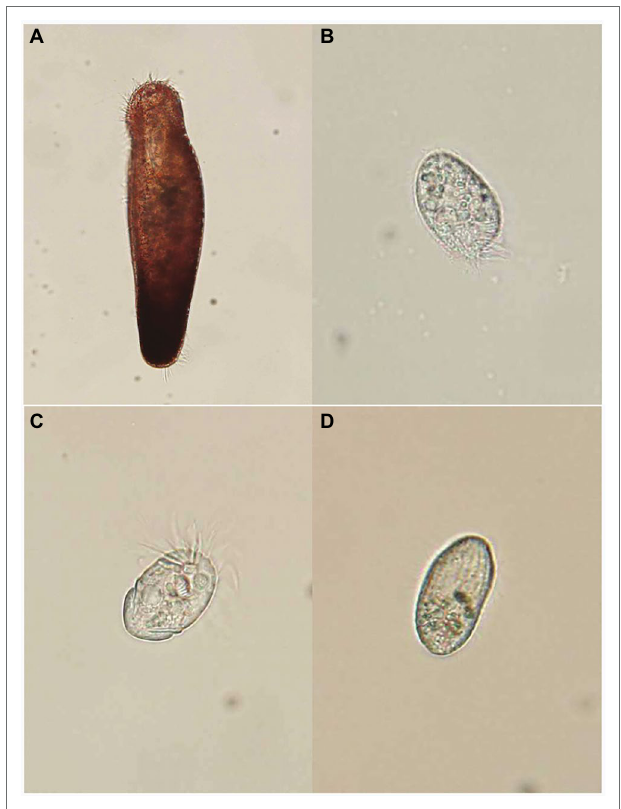
FIGURE 1 | Specimens of four ciliates: (A) Pseudokeronopsis pararubra , (B) Protocruzia labiata , (C) Strombidium sulcatum , and (D) Uronemella filificum